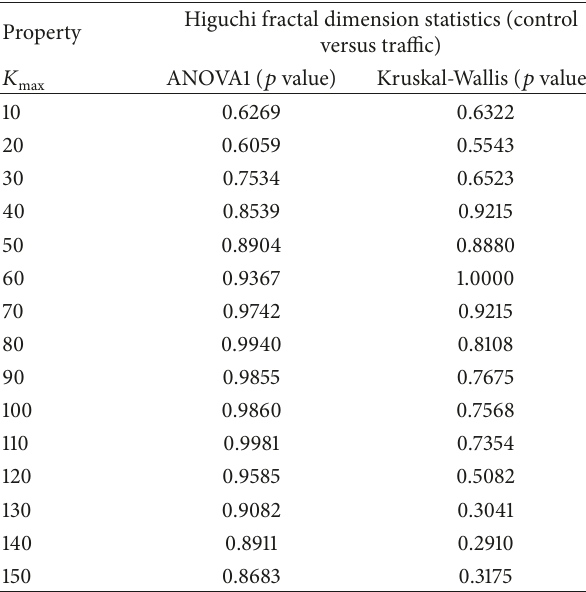
Table 6: Higuchi fractal dimension at varying levels of 𝐾 max between 10 and 150 at equidistant intervals of 10.